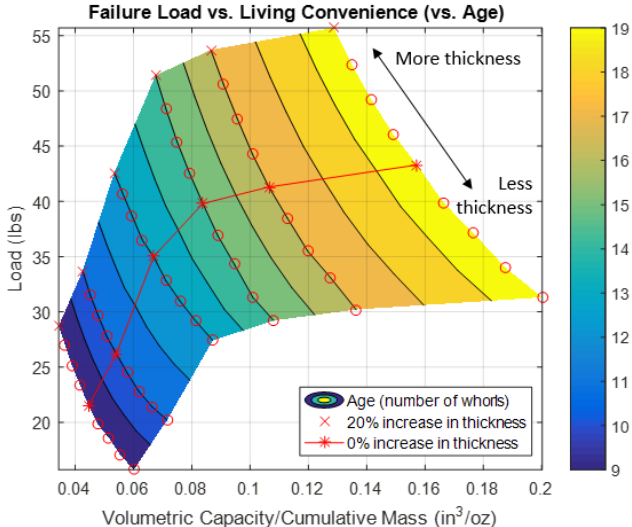
Figure 13. Shells fracture more easily with fewer whorls. Contour levels represent age. Load-to-living convenience rate appears to stabilize after 13–15 whorls.